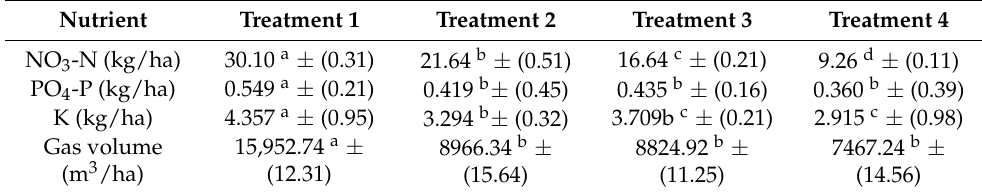
Table 3. Leaching losses of the